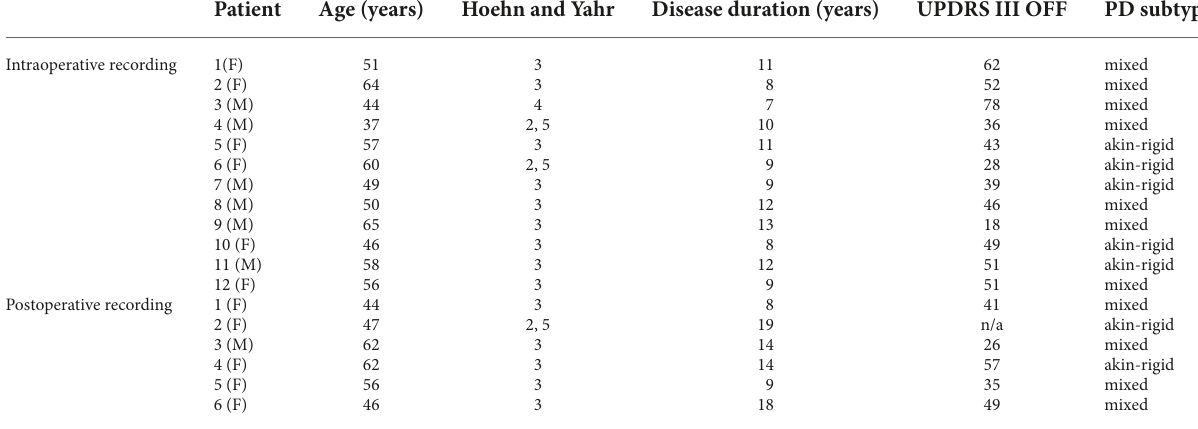
TABLE 1 Clinical characteristics of Parkinson’s disease